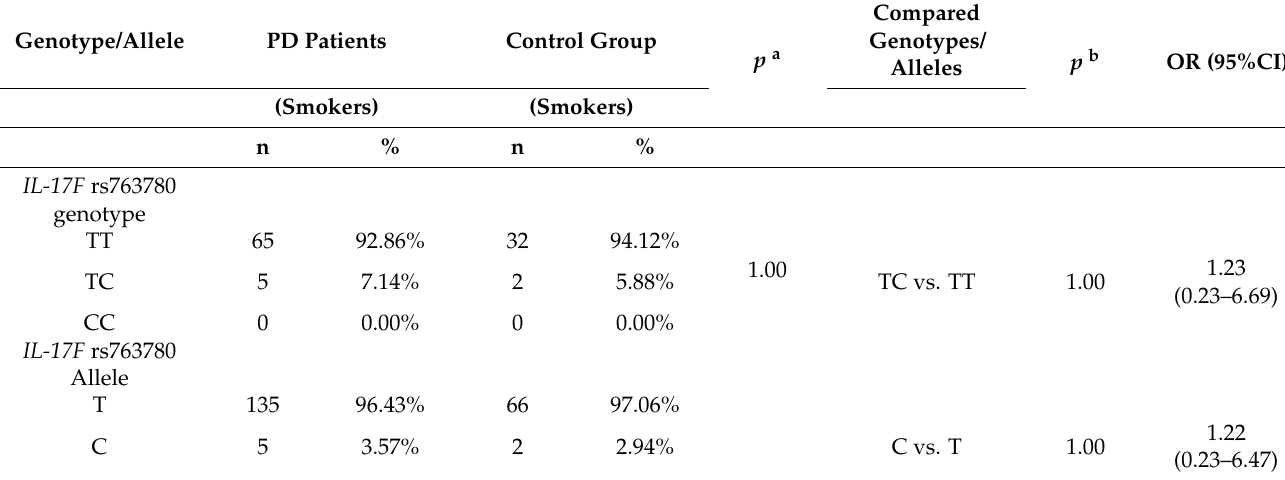
Table 4. The distribution of IL-17F rs763780 and IL-17A rs2275913 genotypes in periodontitis patients and control group in smokers